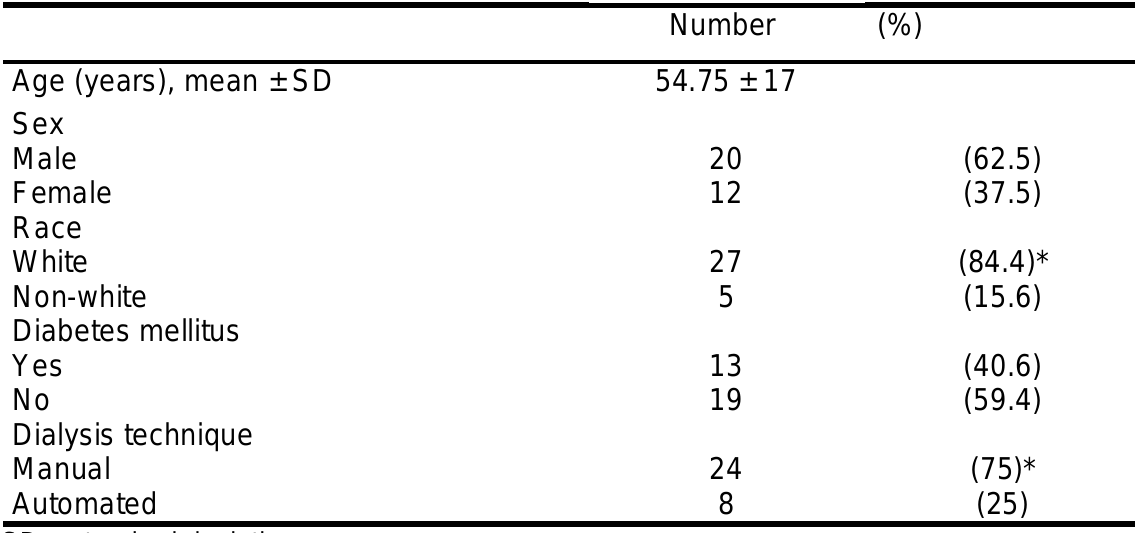
Table 1: Characteristics of the 32 patients included in the study.